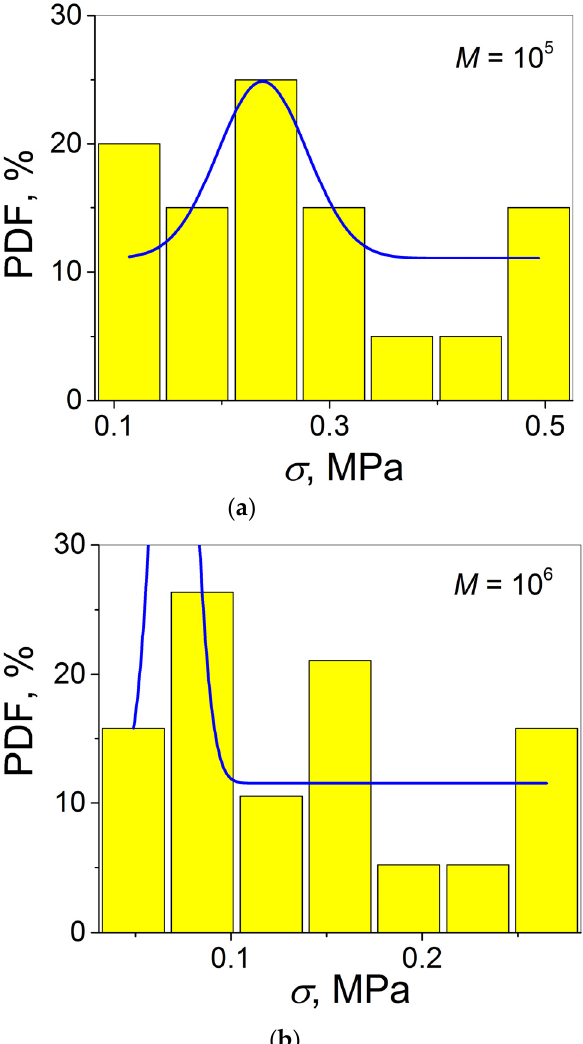
Figure 5. Histograms PDF vs. σ for AJs ( a ) PS1–PS1 and ( b ) PS2–PS2.